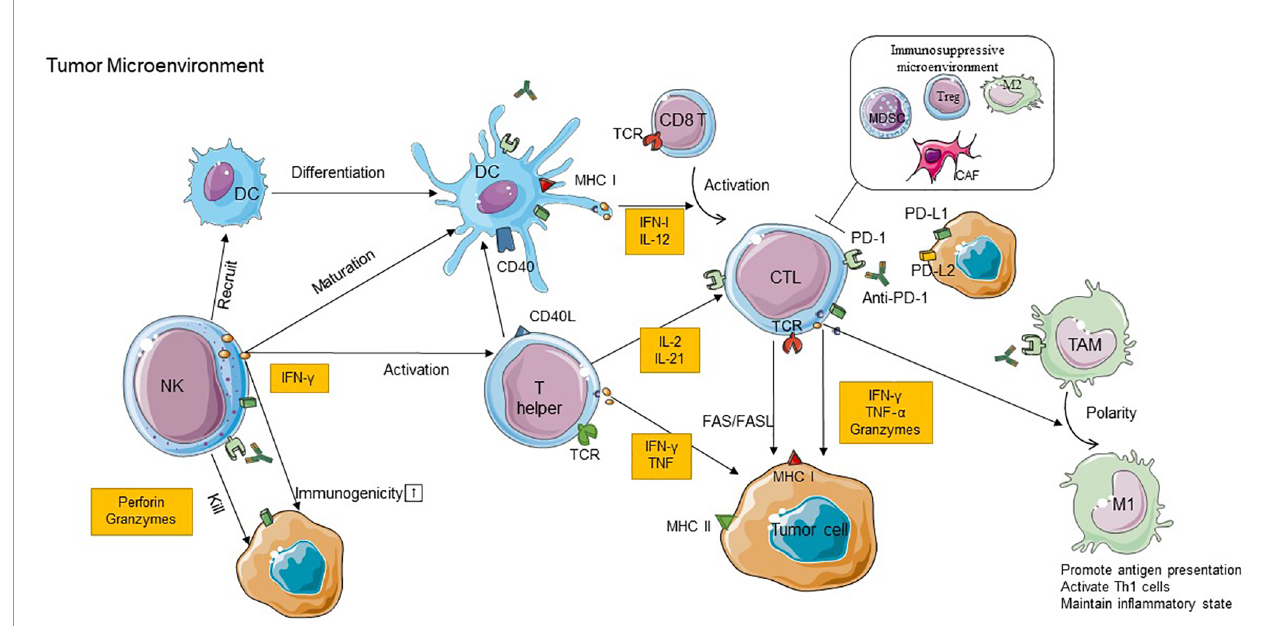
FIGURE 1 | The cross talk between immune cells in TME and the role of immune cells in the ef fi cacy of PD-1 inhibitor therapy. CD8+T cells recognize antigens requiring a corroboration work between CD4+T cells with NK cells and DCs, and M1 TAM can exert antitumoral effects due to the stimulation of IFN- g produced by CD8+ T cells. In addition to these immunostimulatory cells, the immunoinhibitory cells including CAFs, Tregs, M2 TAMs, and MDSCs can construct an immunosuppressive microenvironment to restrict the antitumor effect. Anti-PD-1 binds to PD-1 on immune cells which can block PD-1/PD-L1 interactions and recover the antitumor function of those cells. PD-1, programmed cell death protein 1; PD-L1, programmed death-ligand 1; PD-L2, programmed death-ligand 2; IFN- g , interferon gamma; TNF, tumor necrosis factor; CTL, cytotoxic T lymphocyte; DC, dendritic cell; NK, natural killer cell; MDSC, myeloid-derived suppressor cell; Treg, regulatory T cell; CAF, cancer- associated fi broblast; TAM, tumor-associated macrophage; M1, type 1 macrophage cell; M2, type 2 macrophage cell; MHC, major histocompatibility complex; TCR, T cell receptor; TME, tumor